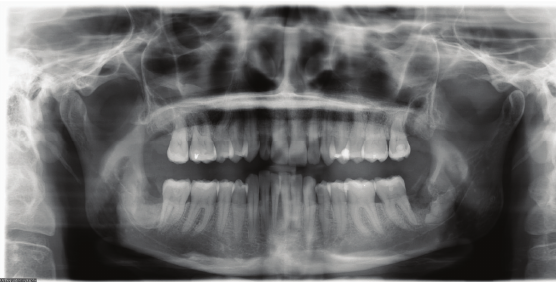
Figure 4: Six days postoperatively. Please note that the bone graft is radiolucent at this stage.